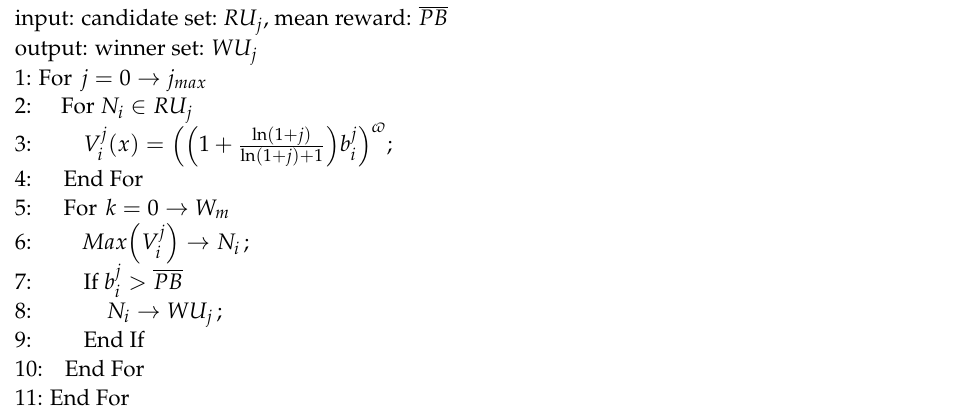
Algorithm 1. Winner Selection Algorithm Based on Risk Preference